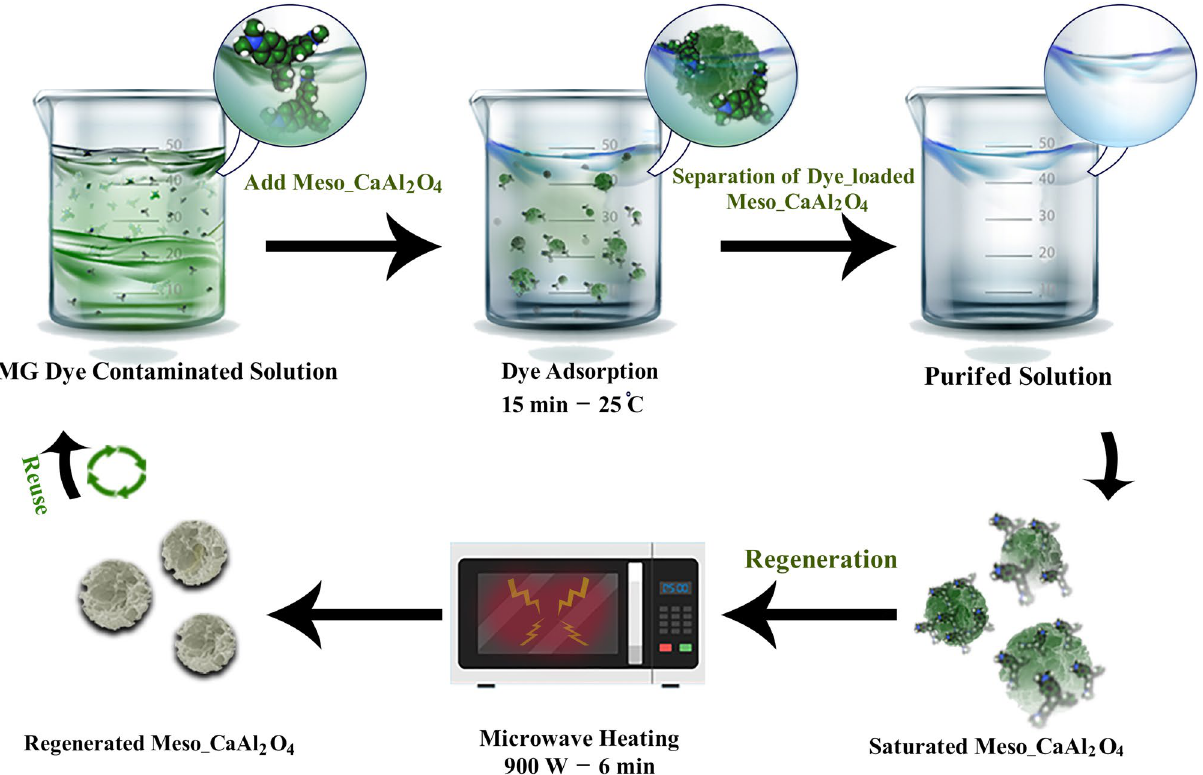
Figure 2. The diagram of the MG dye adsorption by meso-CaAl 2 O 4 and microwave-assisted